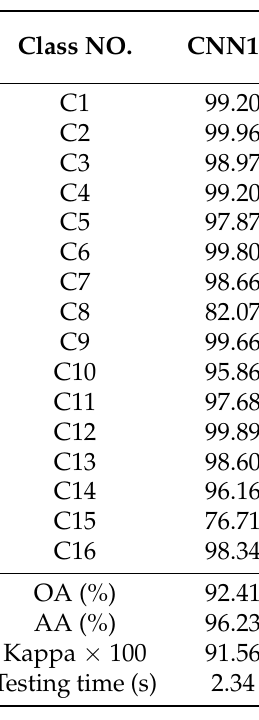
Table 9. Classification results for the SV dataset using 5% of the available labeled